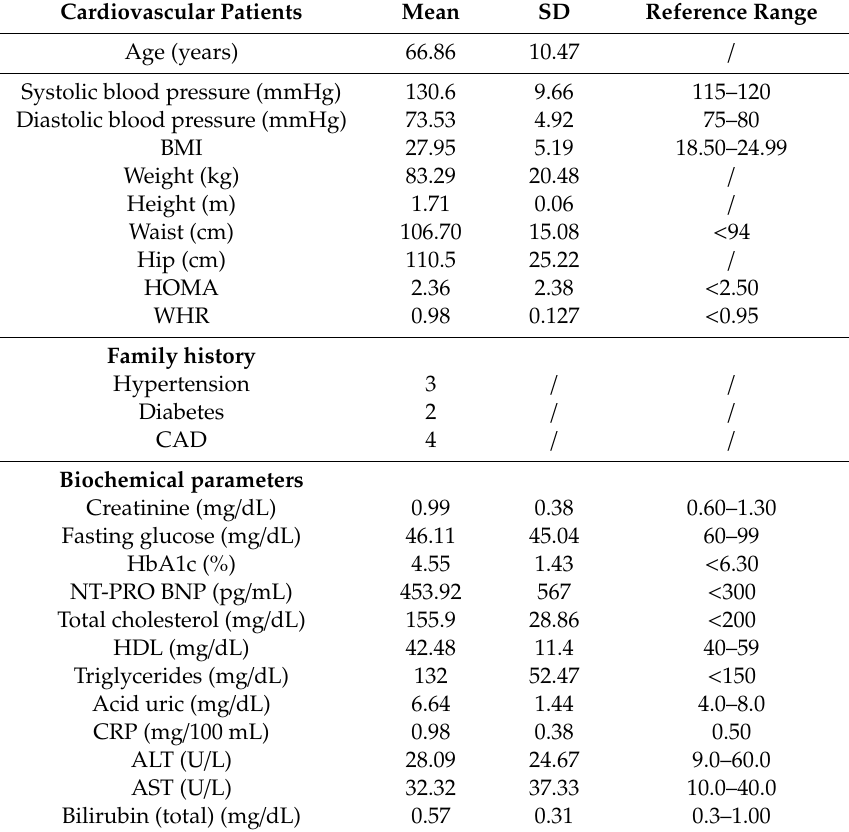
Table 1. Cardiovascular disease (CVD) patients’ main details and echocardiographic assessment.